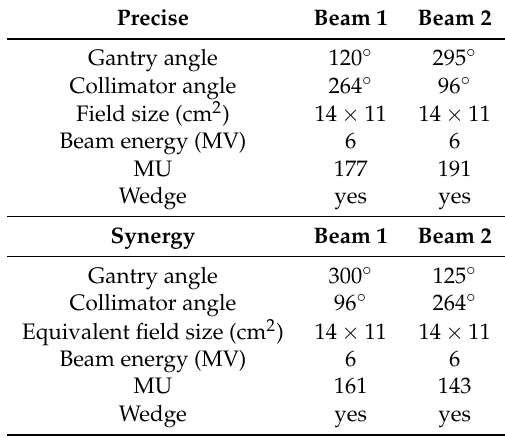
Table 1. Parameters of the two simulated treatment plans used in the